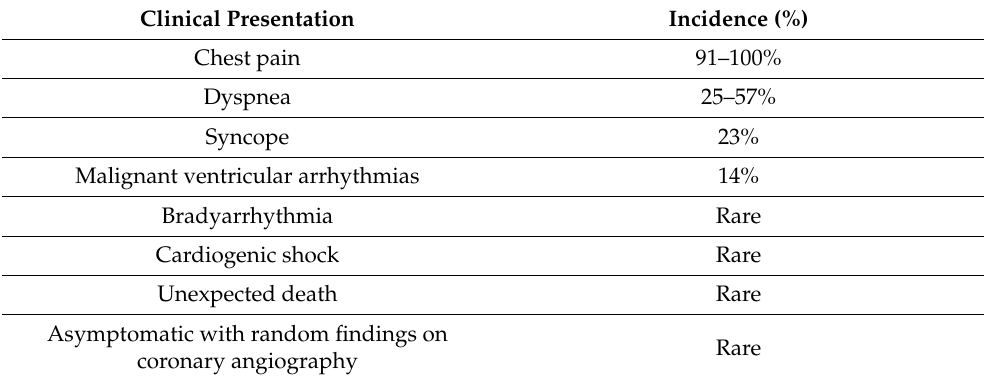
Table 2. Clinical symptoms of spontaneous coronary artery dissection (adapted from